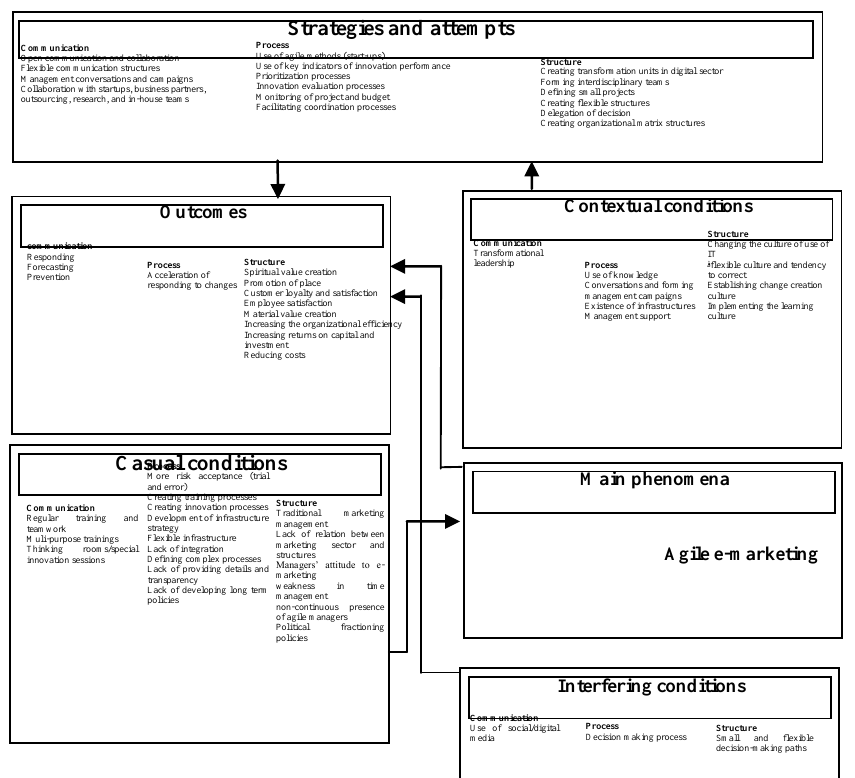
Figure 1. Conceptual model of agile digital marketing in the banking